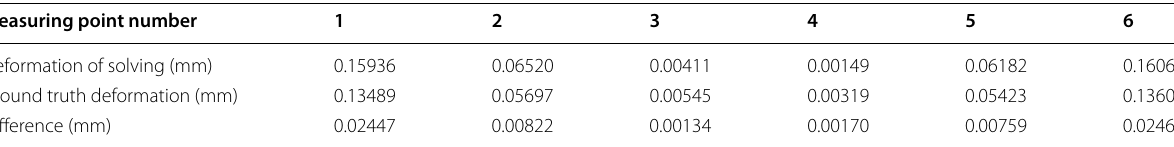
Table 2 The solved deformation values and error compared with ground truth for the milling depth from 1 mm to 7 mm Measuring point